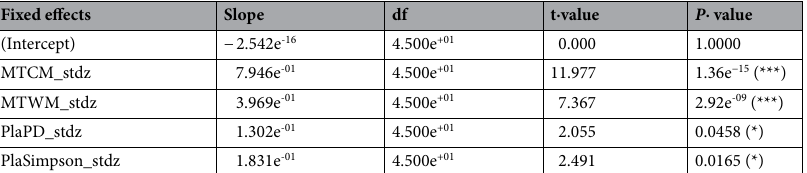
Table 2. Linear mixed-effects model results for the effects of environmental variations (MTCM_stdz and MTWM_stdz) and plant diversity (PlaPD_stdz and PlaSimpson_stdz) on beetles Simpson diversity.